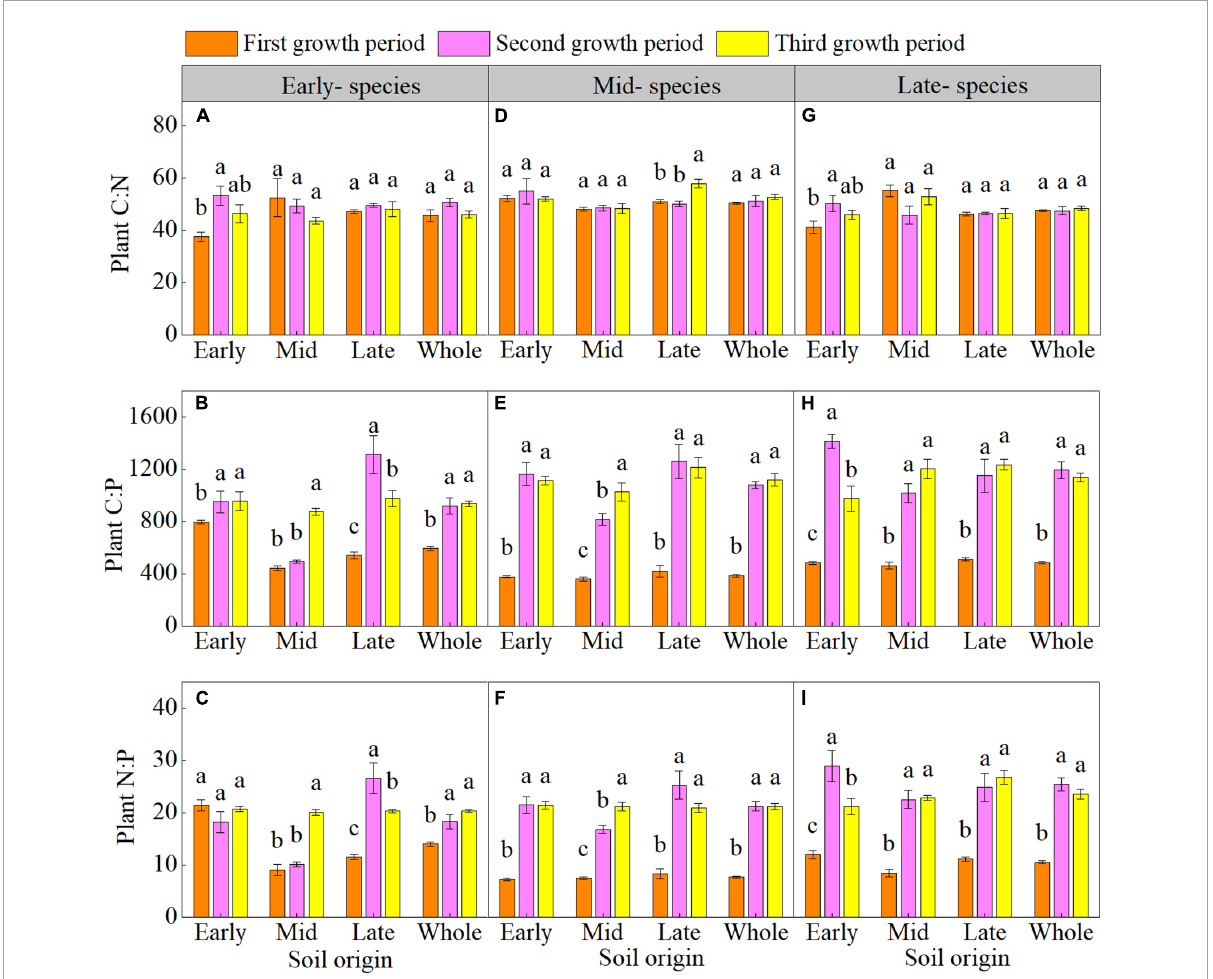
FIGURE1 Mean ( ± SE) ( n = 5) plant carbon-nitrogen-phosphorus stoichiometry (plant C:N, plant C:P, and plant N:P) of early- (A–C) , mid- (D–F) , and late- species (G–I) over the three growth periods. “Whole” is the average plant C:N, plant C:P, and plant N:P of the same species in the three soils. Different lower letters indicate significant differences in mean plant C:N, plant C:P, and plant N:P among the three growth periods based on Duncan’s post-hoc test ( p <